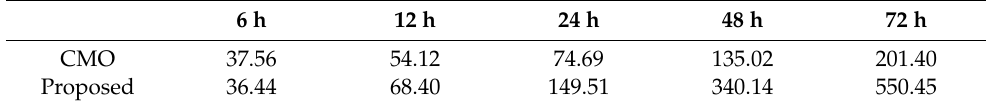
Table 11. Long-term distance error of CMO and proposed method